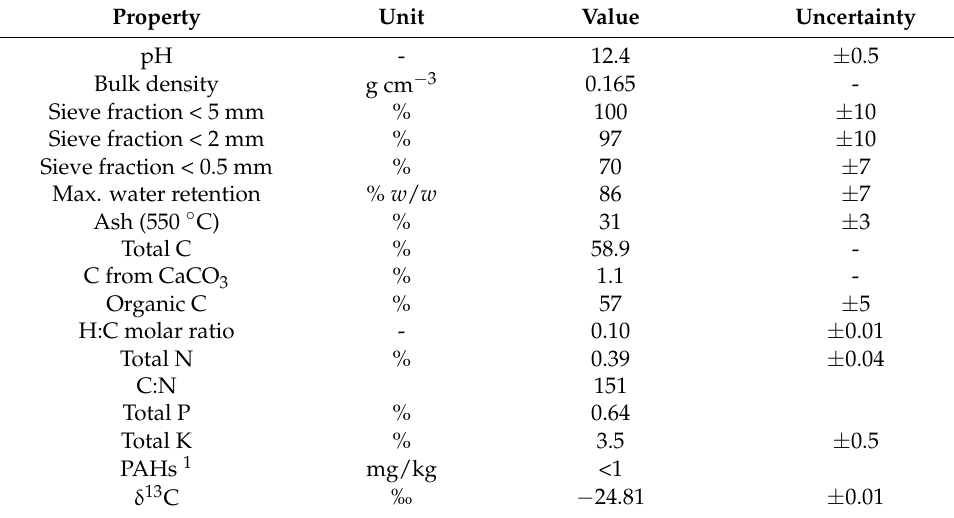
Table 1. Physicochemical characteristics of the biochar used in the present work. Property Unit Value Uncertainty pH - Bulk